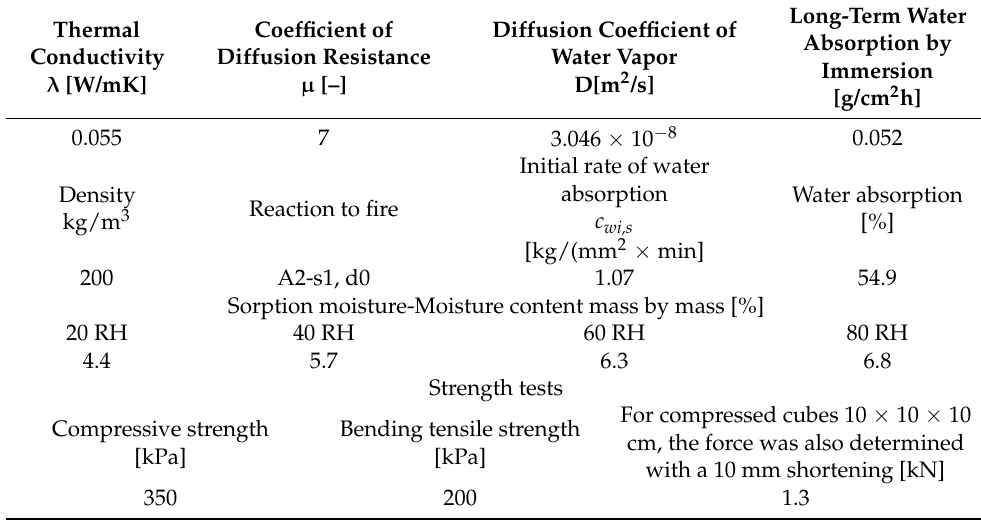
Table 3. Results of laboratory tests.